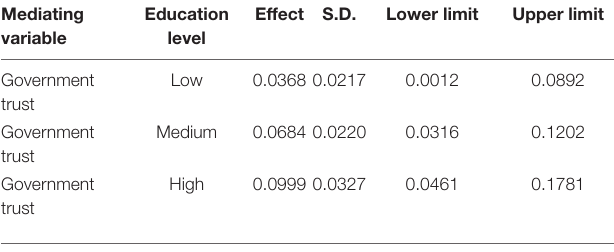
TABLE 3 | Test on the mediating effect with